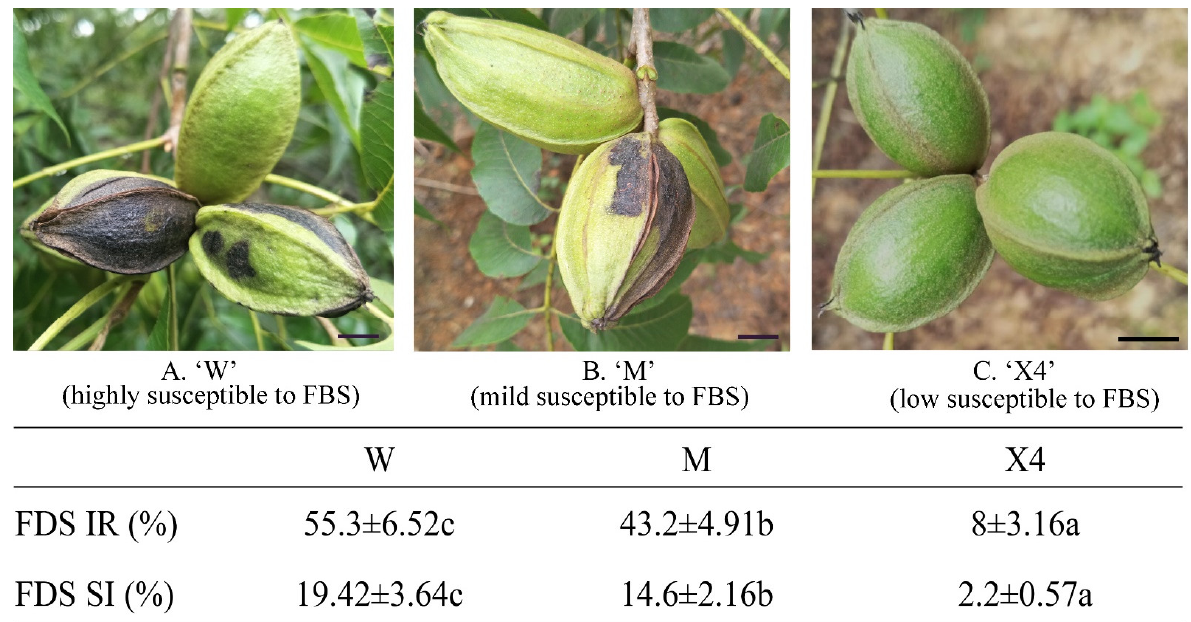
Figure 1. Symptoms and incidence rate (IR)/severity index (SI) of pecan fruits after FBS infection. Percentage of IR/SI is expressed as mean ± standard error ( n = 12). Scale bar = 1 cm. IR was calculated as total infested fruits/total fruits; SI was calculated as Σ(α i ·n)/(A·N). X4, Xinxuan-4; M, Mahan; W, Wichita. Different letters (a–c) indicate significant difference ( p < 0.05).